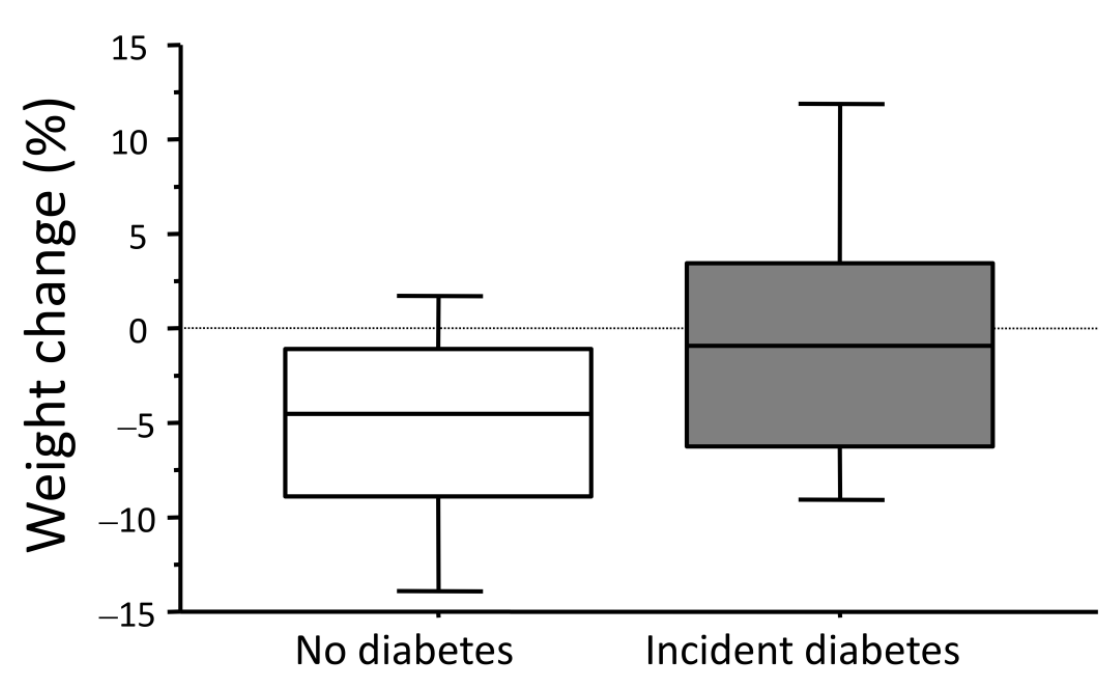
Figure 2. Percent weight change in relation to incident diabetes in subjects without diabetes at entry. Legend: Statistically different between groups ( p < 0.001).